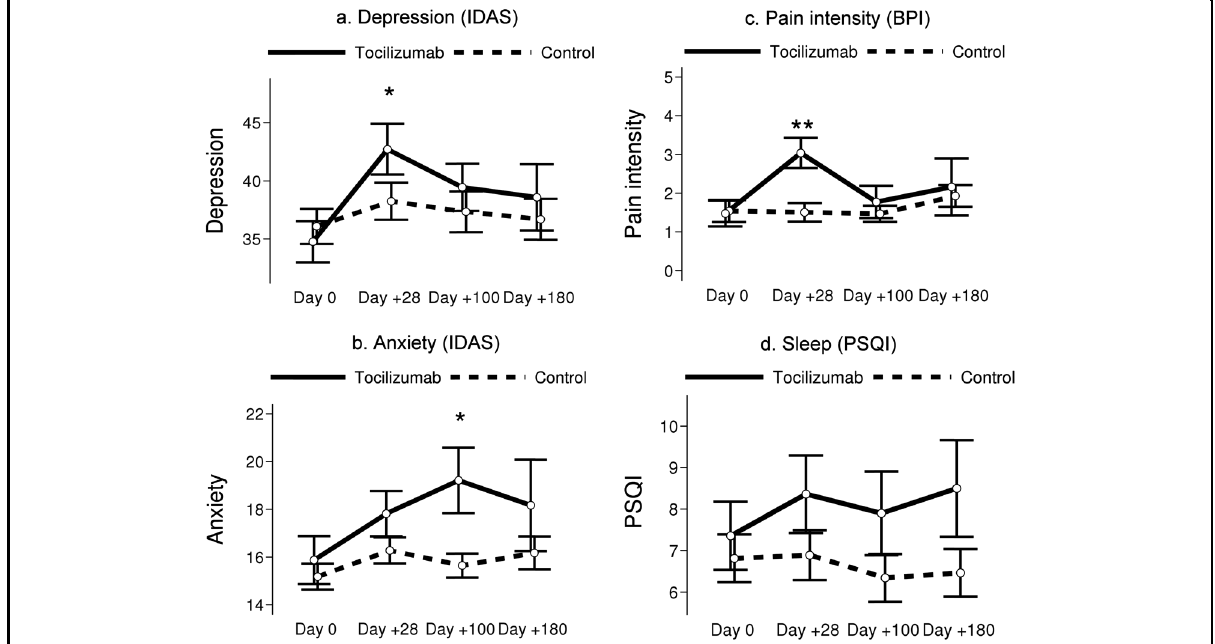
Fig. 1 Mean patient-reported outcome scores by study group and time. Error bars represent standard errors. Signi fi cance stars are based on ANCOVA after adjusting for baseline depression (* P = 0.01 – 0.05, ** P <